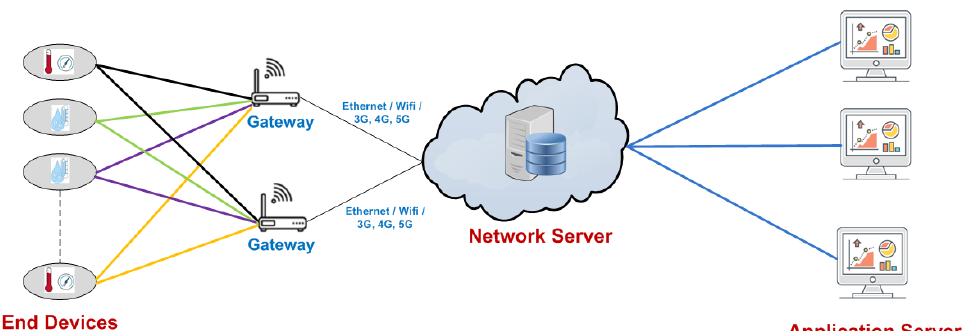
Figure 2. Long Range Wide Area Network (LoRaWAN) architecture.